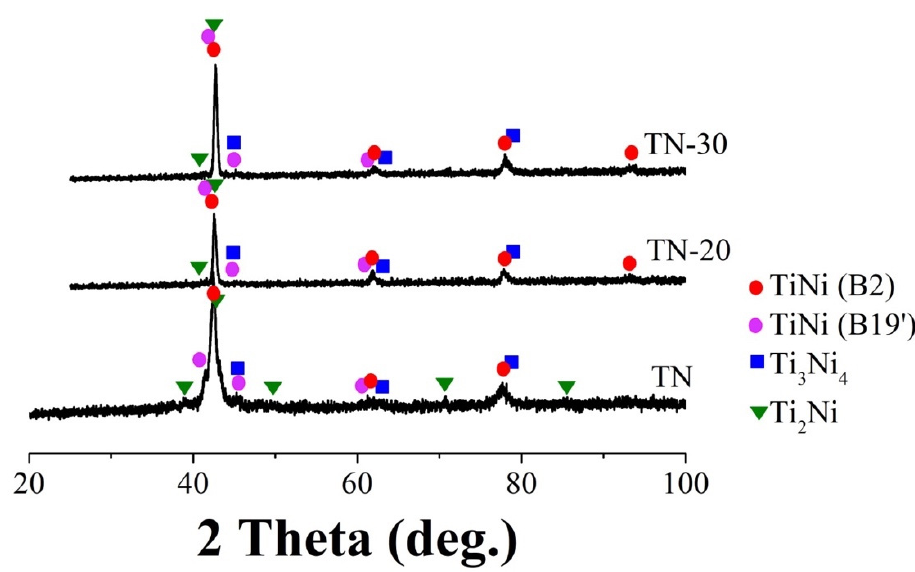
Figure 2. XRD patterns of samples prepared in this study from TiNi powder and monolith TiNi substrates.